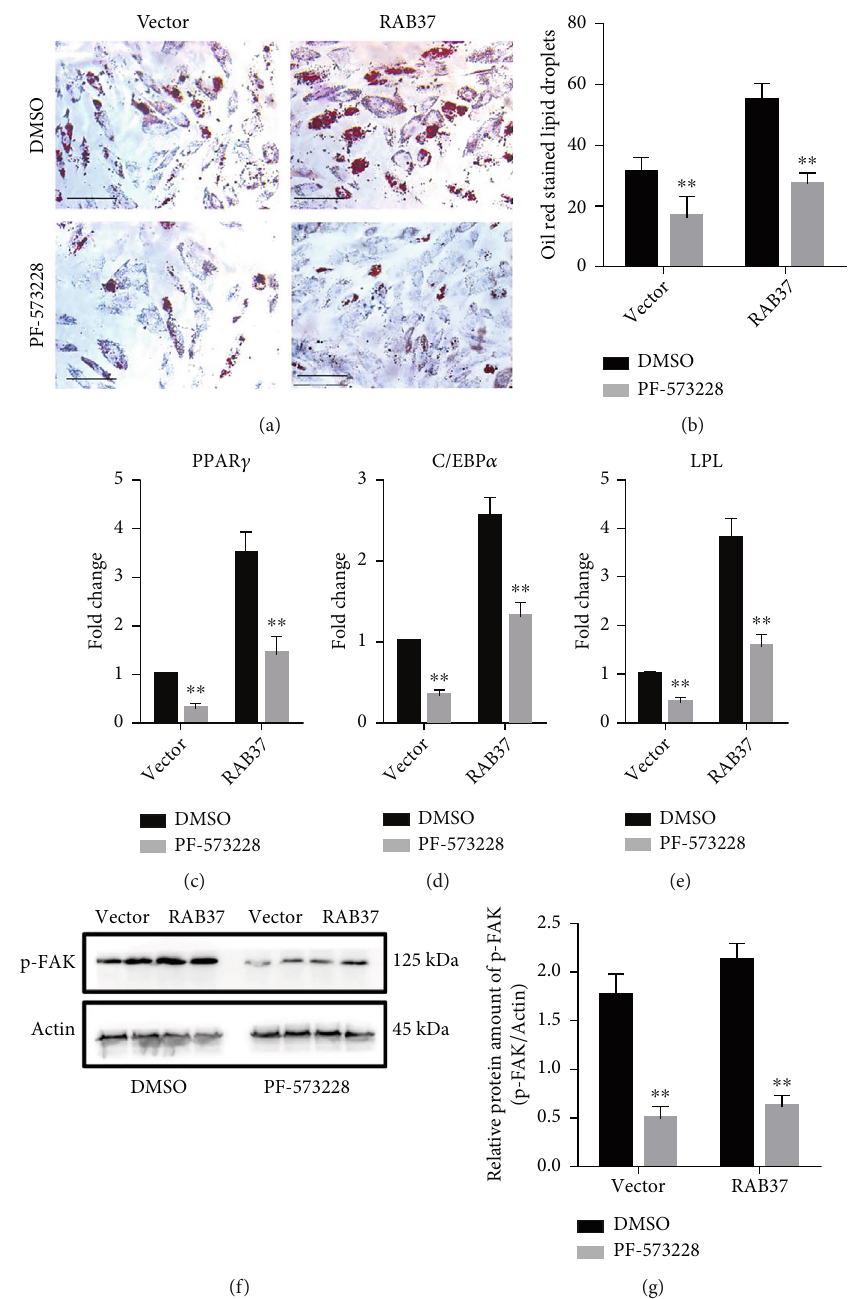
Figure 7: An inhibitor of FAK impeded RAB37-mediated adipogenic di ff erentiation RAB37-hADSCs was pretreated with PF-573228, an inhibitor of FAK, and then subjected to induction of adipogenic di ff erentiation for 5 days. DMSO was used as control for PF-573228. Adipogenic di ff erentiation was evaluated by Oil Red O staining (a); scale bar = 300 μ m . Oil Red O-stained hADSCs in six random views were counted (b), n = 6 . The expression of PPAR γ (c), C/EBP α (d), and LPL (e) was examined by qRT-PCR, n = 3 . The accumulations of phosphorylated FAK in hADSCs were examined by western blotting (f). (g) Quantitative analysis of phosphorylated FAK, n = 3 . Data are presented as mean ± SD . ∗∗ p < 0 : 01 ; DMSO vs.